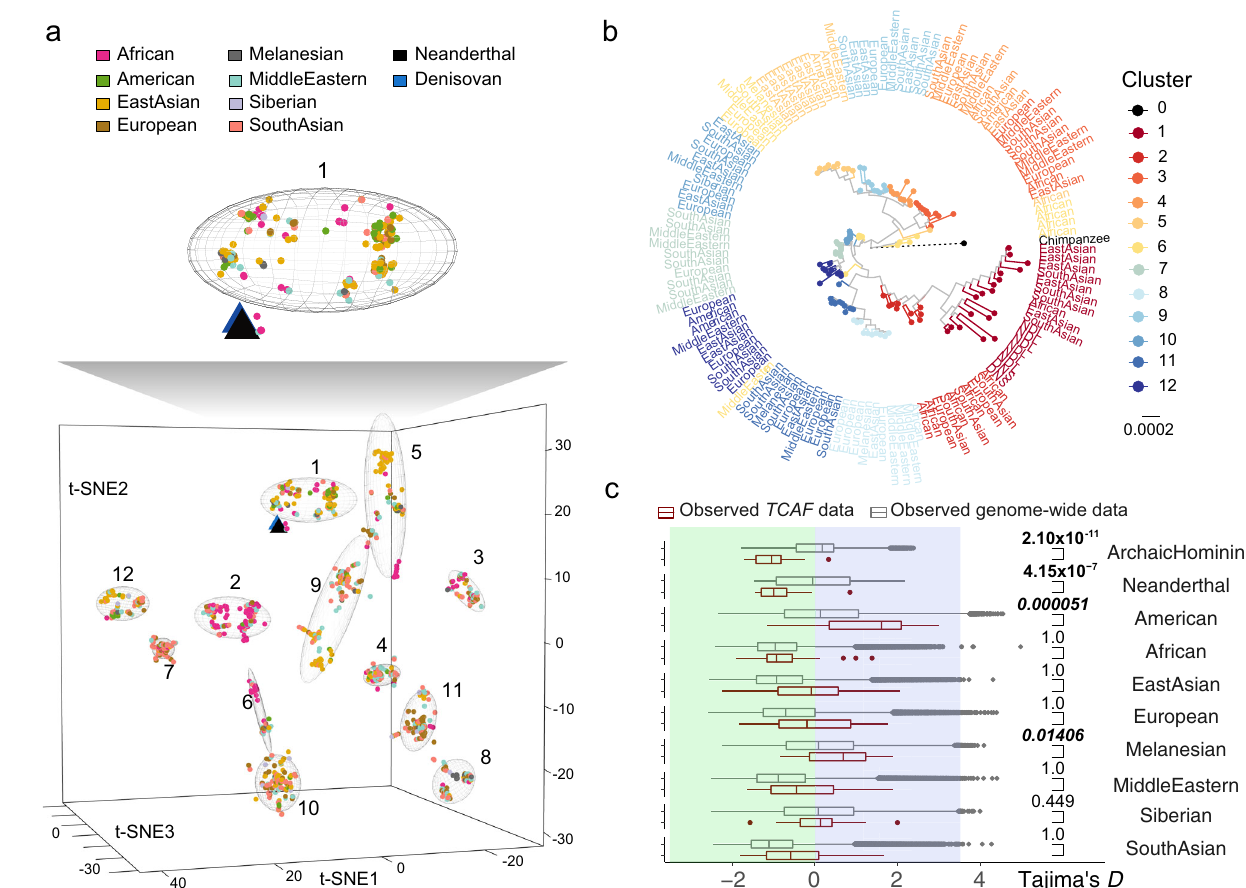
Fig. 5 Archaic hominin versus human haplotype diversity. Haplotypes were inferred using 1,275 SNVs in the three unique diploid sequences around the TCAF SD region (Fig. 1). a Haplotype-based principal component analysis (PCA) was performed, followed by haplotype clustering and cluster visualization using t-SNE — a dimension-reduction technique (Methods). On the t-SNE plot, each dot/triangle is a haplotype and colored according to population/ species origin. Neanderthal and Denisovan haplotypes are indicated by the black and blue triangles, respectively. Numbers and ellipses in the 3D t-SNE plots indicate individual clusters (Supplementary Figs. 27 – 32). The zoom-in above the 3D t-SNE shows that all archaic haplotypes are in close proximity to each other and associate with cluster 1. b The maximum likelihood phylogeny was constructed using 10 randomly selected haplotypes from the 12 inferred clusters, in addition to eight archaic and one chimpanzee haplotypes. Note that the branch length of chimpanzee (dashed line) is truncated by 90% of its actual length for the purpose of illustration. c Comparisons of the Tajima ’ s D distributions between the TCAF locus and the entire genome in human and archaic populations. Tajima ’ s D statistics are computed for individual archaic and modern groups across the entire genome (gray) versus TCAF (red) based on 2 kbp windows. For each boxplot, the lower and upper hinges correspond to the fi rst and third quartiles, respectively, in addition to the median value. The upper and lower whiskers show 1.5 * IQR from the upper and lower hinges, respectively, where IQR is the inter-quartile range de fi ned as the distance between the fi rst and third quartiles. P values (one-tailed) are empirically determined by testing if the observed values at TCAF (29 windows) are signi fi cantly more negative (green) than those from the genome (1,224,349 windows), except for the American and Melanesian groups, where their p values indicate if the observed D values at TCAF are signi fi cantly more positive (italic) than the those from the genome. Bold fonts indicate Bonferroni ’ s p values (one-tailed) <